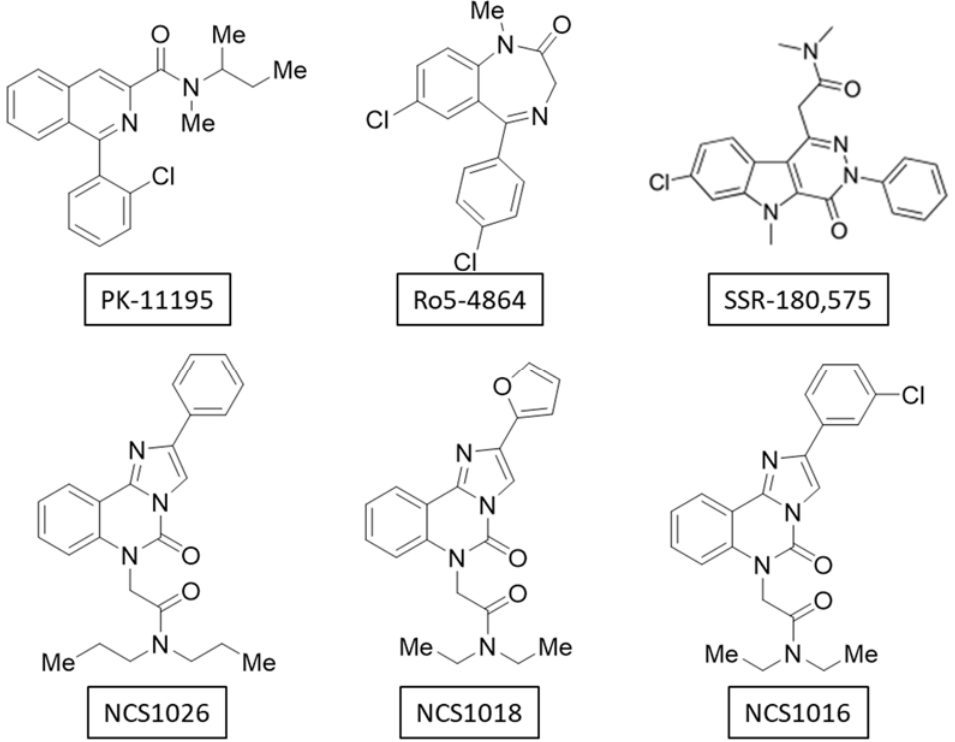
Figure 7. Chemical structure of the TSPO ligands. The six TSPO ligands used in this study belonged to the isoquinolines (PK 11195), benzodiazepines (Ro5-4864), pyridazinoindoles (SSR-180,575), and imidazoquinazolinone-derivative (NCS1016, NCS1018 and NCS1026) families.